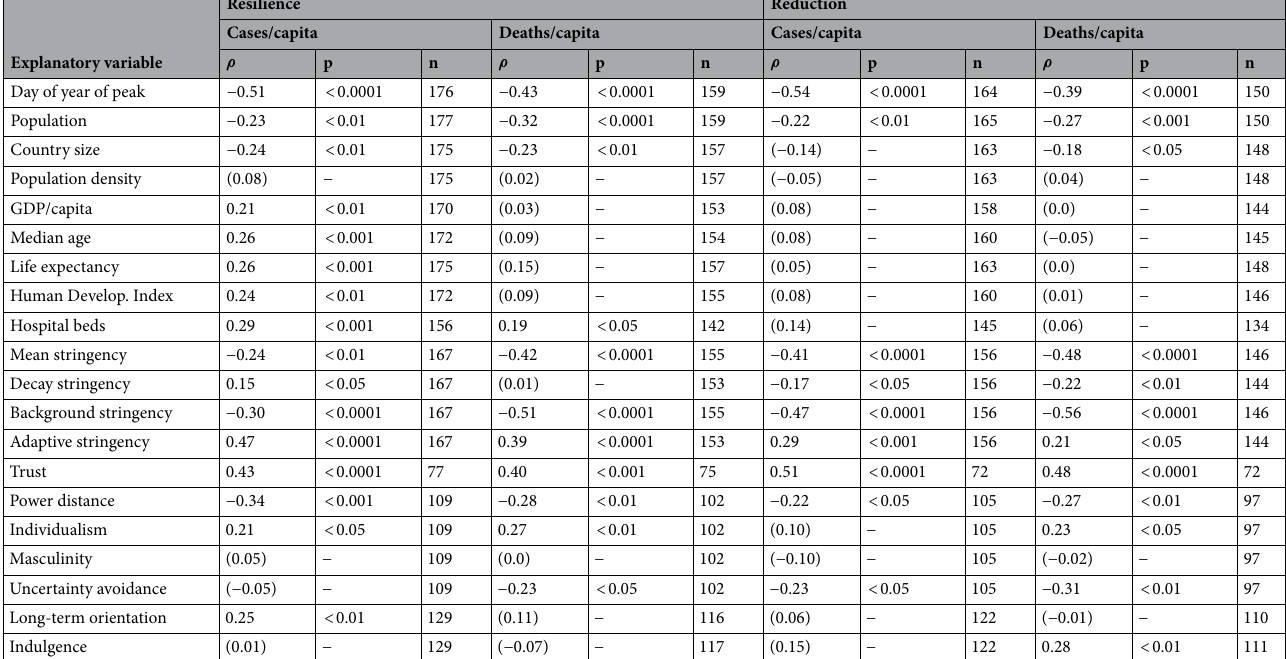
Table 1. Factors correlating with resilience (decay rate) and reduction of COVID-19 cases and deaths across countries. Pairwise Spearman’s rank correlations.